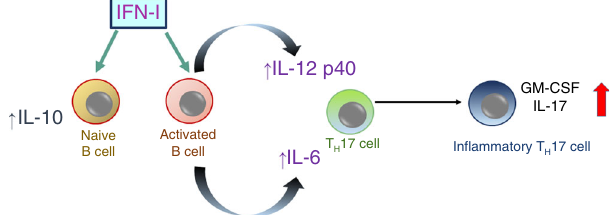
Fig. 10 IFN-I indirectly promotes TH17 pathogenicity. Data from Fig. 9 indicate that IFN-I stimulates the expression of IL-6 and IL-12p40 from activated B cells which, in the context of auto-antigen, supports the proliferation of in fl ammatory TH17 cells. In contrast, IFN-I stimulation of naive B cells elevates IL-10 and not IL-6 and does not ef fi ciently promote in fl ammatory TH17 cell